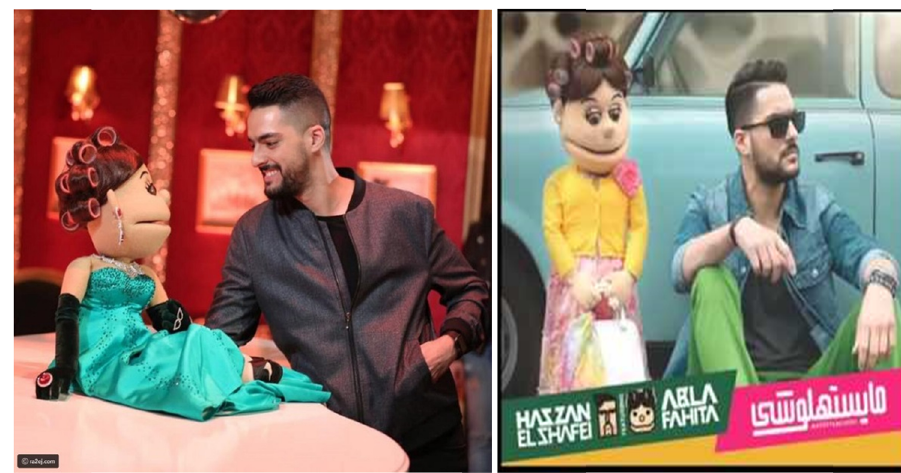
Figure 3: Abla Fahita with Hassan Elsha fi